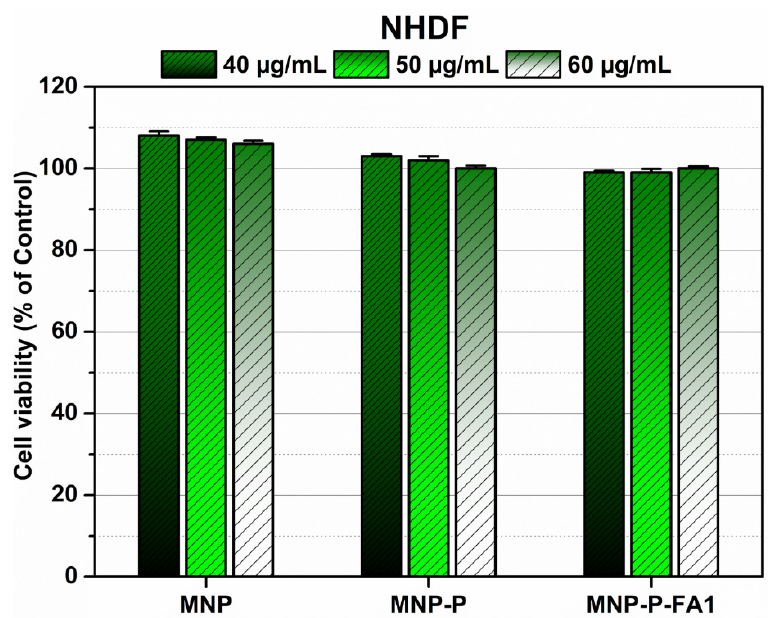
Figure 9. Biocompatibility of MNP, MNP-P and MNP-P-FA1 (40, 50 and 60 µ g/mL) on normal human dermal fibroblasts (NHDF) after 24 h. Experiments were performed in triplicate, and treated cell viability was expressed as percentage of control cells’ viability. Data were represented as means ± standard error of the mean.